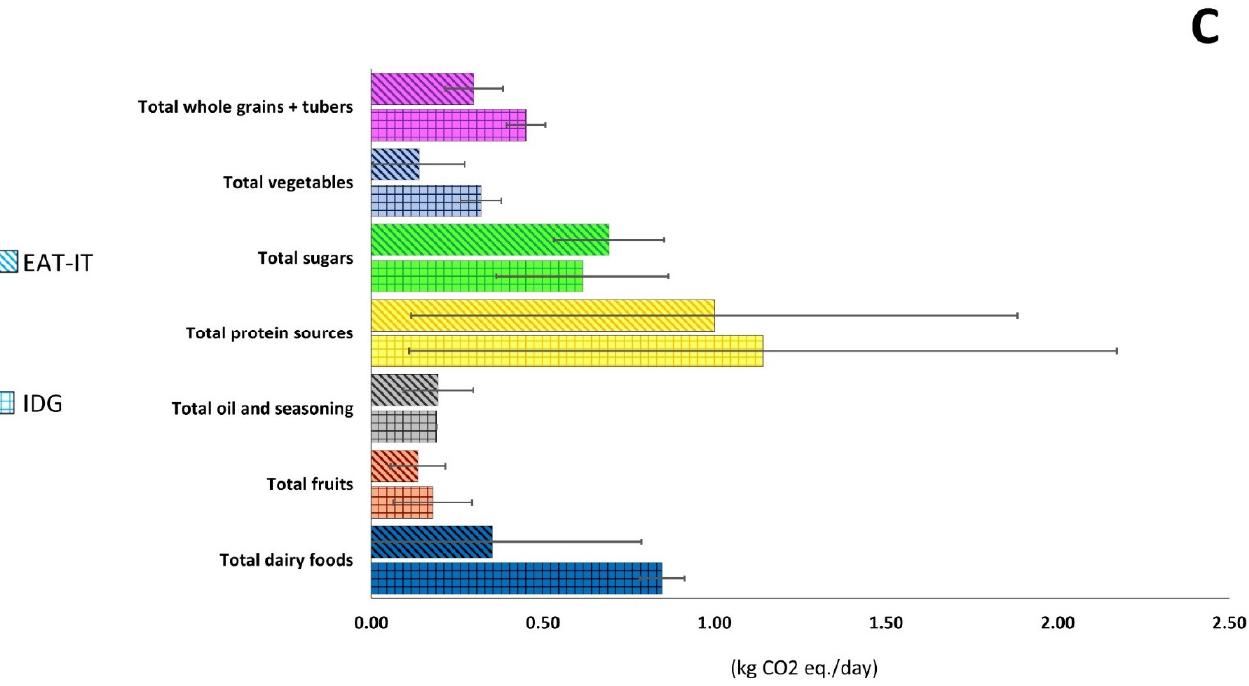
Figure 2. Total ( A ) carbon footprint associated with EAT-IT and IDG dietary patterns and relative ( B ) and percentage ( C ) contribution of the different food groups. Legend: EAT-IT: EAT-Lancet Commission reference diet (adapted to the Italian food habits); IDG: Italian Dietary Guidelines; CF: carbon footprint; *: statistically significant differences ( p < 0.05)